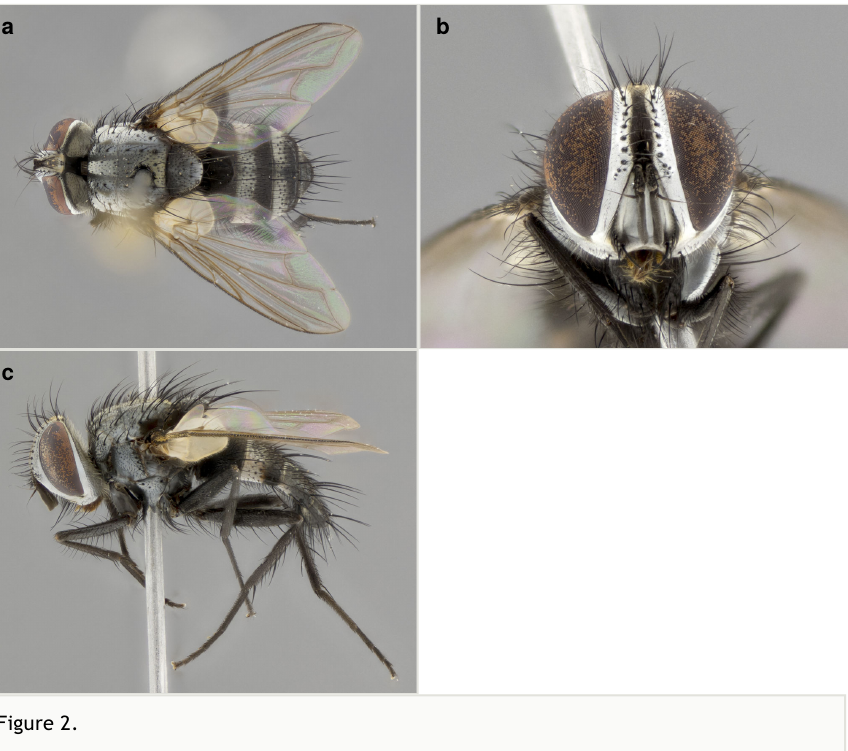
lower level of pedicel; fi rst fl agellomere short of facial margin by 2X length of pedicel. Thorax (Fig. 2a, c): dorsum gray tomentose with 4 dorsal vittae barely visible presuturally, postsuturally all blurred together into a black smudge with a dark overall appearance (this trait only visible under natural light, not pictured); thorax gold tinged on posterior edge adjacent to scutellum; scutellum silver tomentose over black ground color; katepisternum, anepisternum and anepimeron silver-gray tomentose; 3 strong katepisternal bristles; 2 pairs of short discal scutellar bristles; apical scutellars weak and crossed. Legs: tibiae black overall, with light silver tomentosity visible under certain angles of light. Wings: smoky gray, bearing 2–3 short setulae dorsally at base of vein R . Abdomen (Fig. 2a): ground color of abdomen dark brown-black laterally, black dorsally; ST1+2 all black, with mid-dorsal depression extending halfway to margin of syntergite; anterior margins of T3 and T4 bearing gray tomentum covering ⅓ of tergal surface; gray tomentum absent from T5; ST1+2 and T3 with 1 pair of median marginal bristles; T3 and T4 each with 1 pair of underdeveloped median discal bristles; T4 and T5 each bearing 1 row of marginal bristles; no discal bristles on T5. Male terminalia : not dissected.